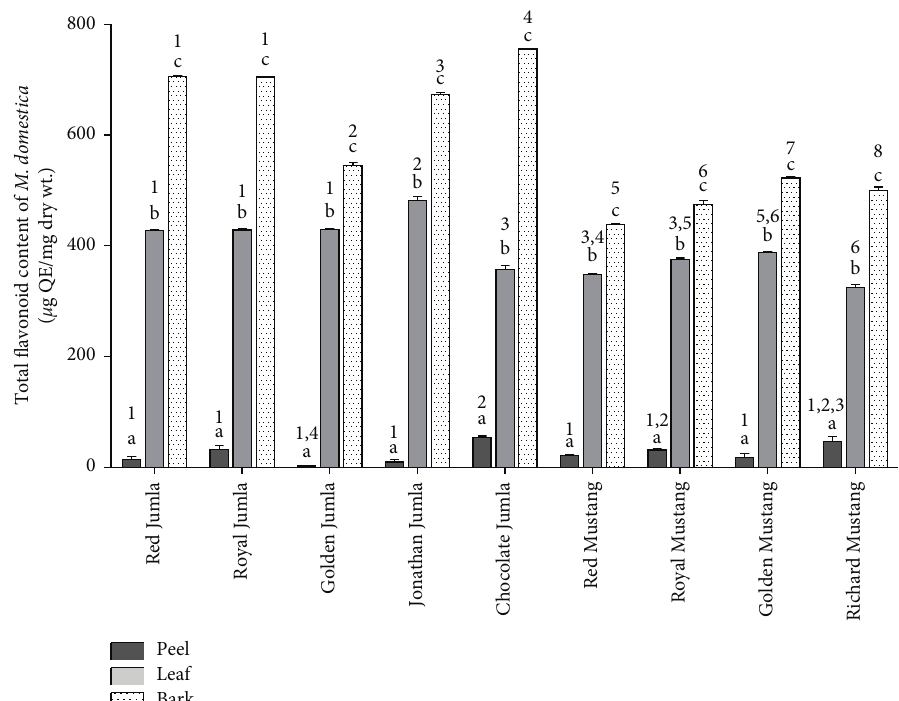
Figure 2: Total flavonoid content of methanolic extract of peel, leaf, and stem bark in different M. domestica cultivars from two different regions of Nepal. Different letters (a–c) on bars indicate significant differences ( P < 0 . 05) between peel, leaf, and bark within the same cultivar. Different numbers (1–8) on bars indicate significant differences ( P < 0 . 05) among the cultivars for same plant parts (peel, leaf, or